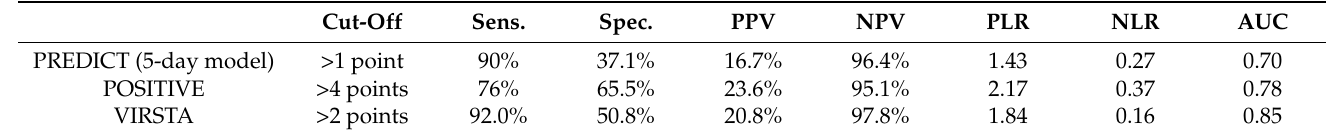
Table 3. Validation of different clinical prediction rules to identify IE among SAB